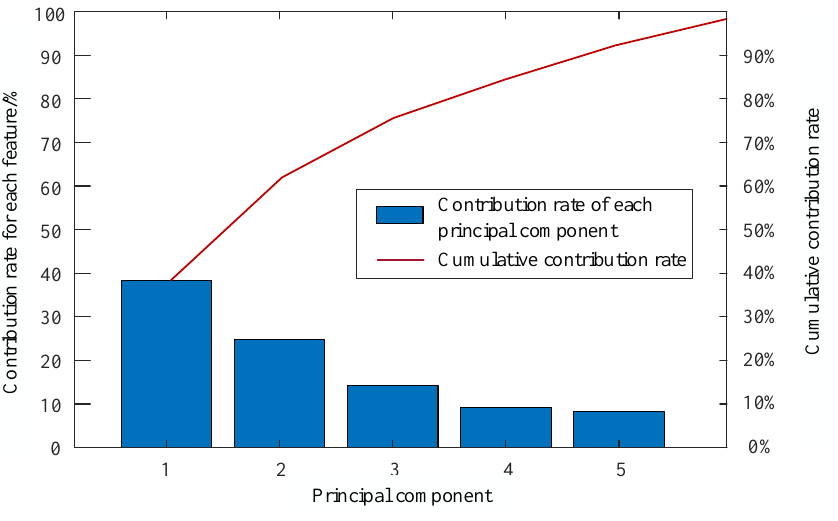
Figure 6. Dimensional reduction graph of KPCA. The visualization of three-dimensional features without KPCA is shown in Figure 7. Because the data of some normal states and the data of a flooding fault are taken from the same fault experiment, they are overlapped. Most of the data of the three states are distributed in different independent regions of three-dimensional space. If the data are presented in the five-dimensional feature space, the three types of fault feature data can be separated and easily distinguished, so the extracted five-dimensional fault feature vector can be used in the subsequent fault diagnosis process.